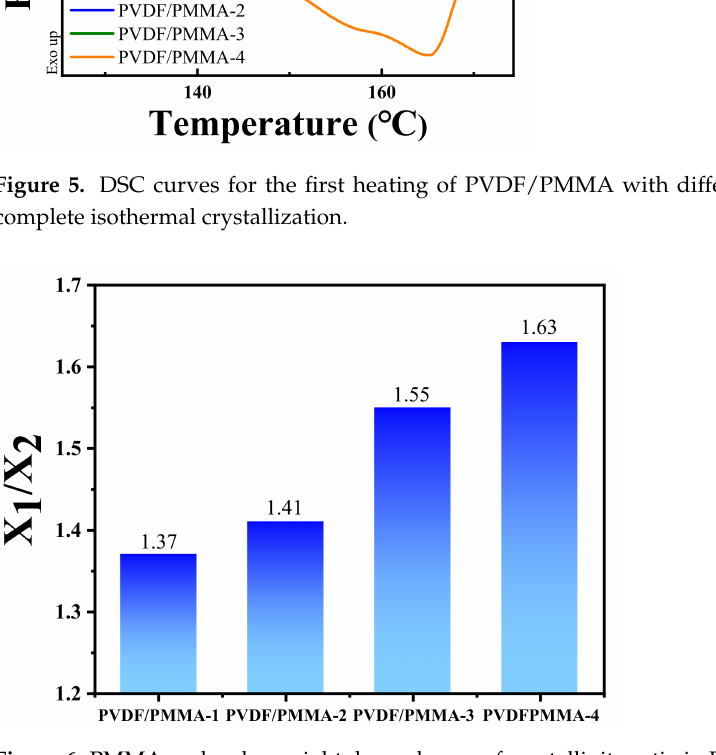
Figure 6. PMMA molecular weight dependences of crystallinity ratio in PVDF/PMMA